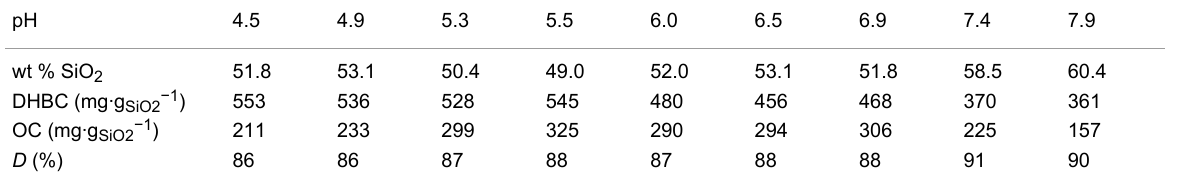
Table 2: Chemical composition of the as-synthesized hybrid materials synthesized at 3.9 wt % DHBC. pH